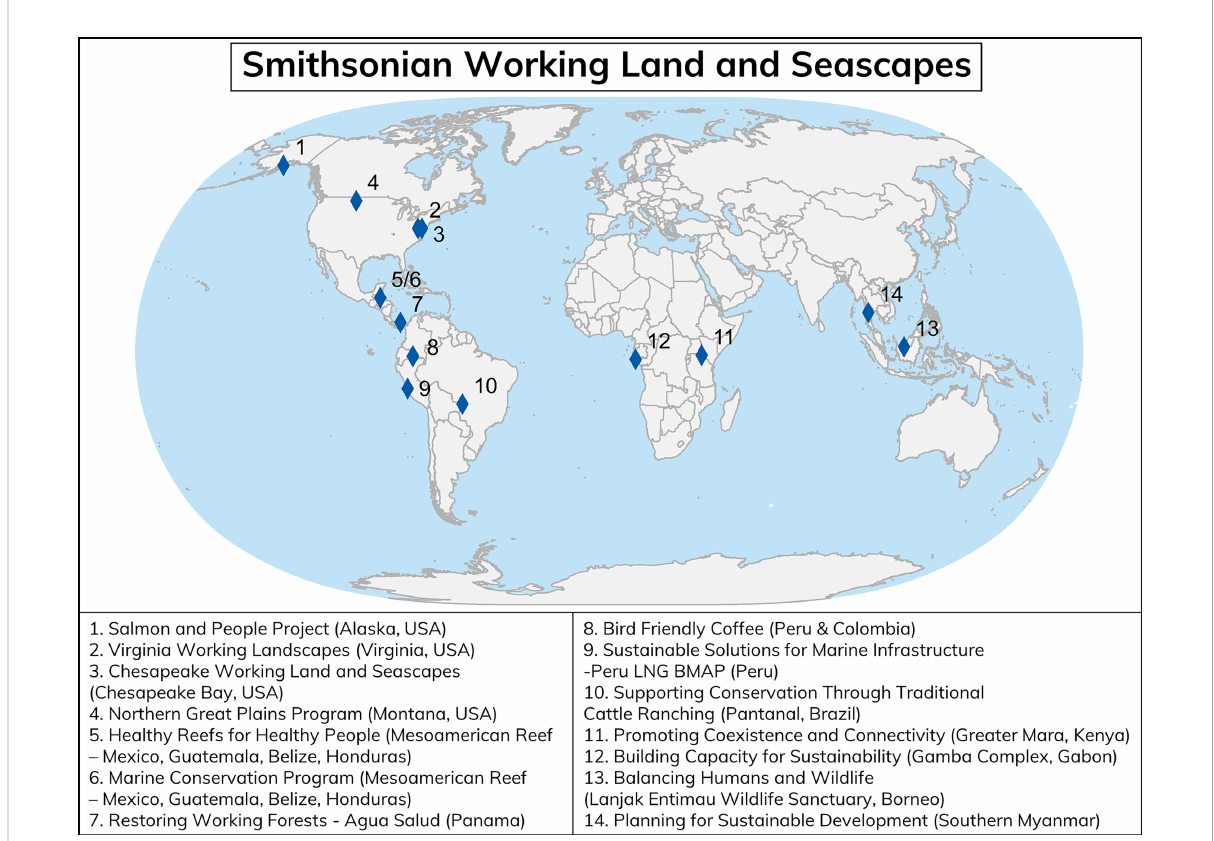
FIGURE 2 Map of locations of Smithsonian Institution ’ s Working Land and Seascape Initiative projects (Credit: Craig